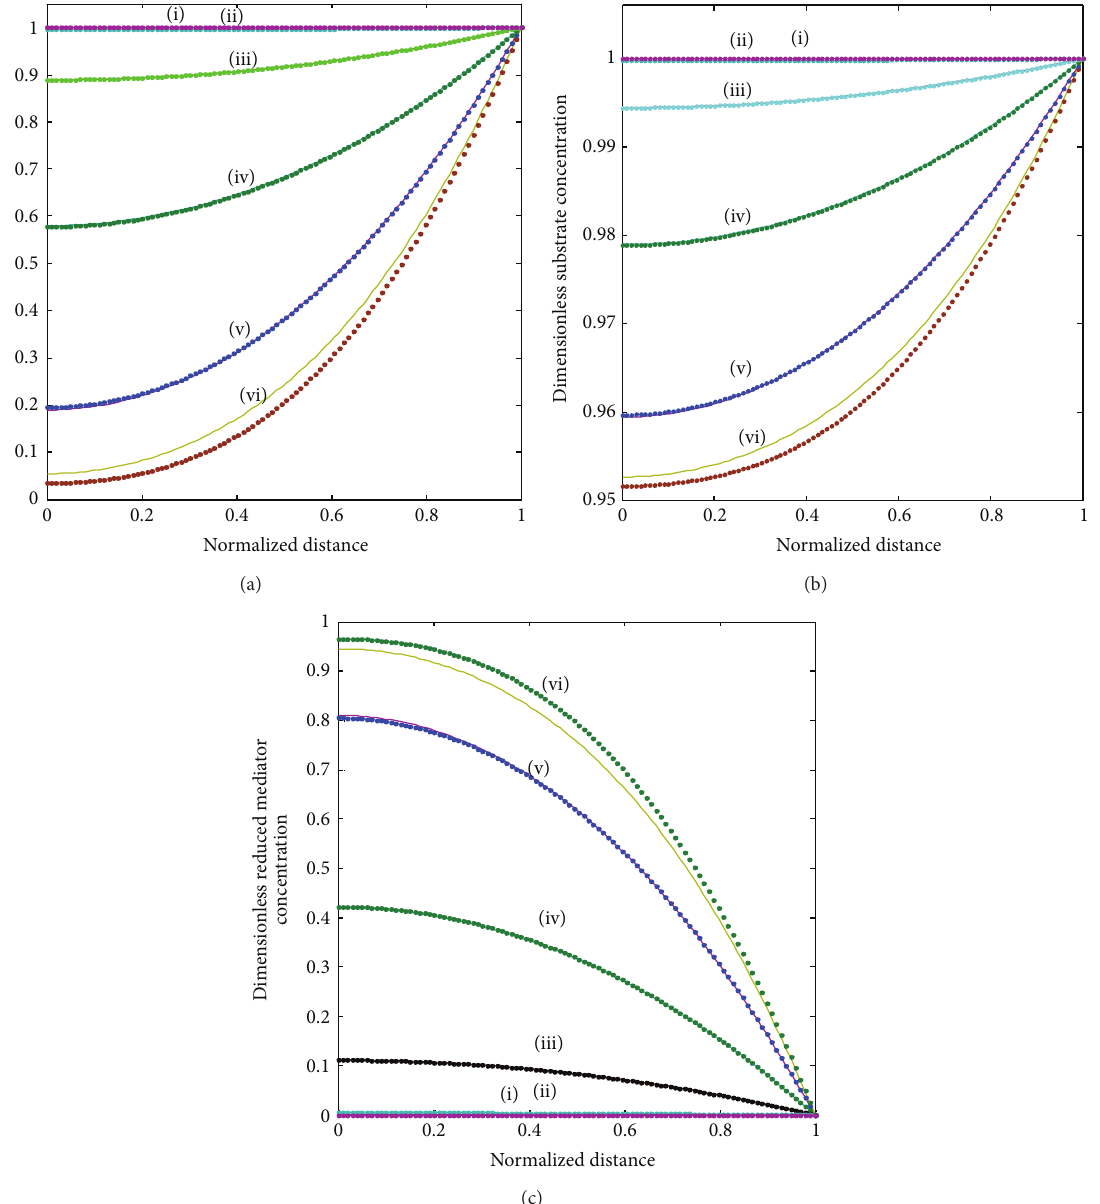
Figure 3: Dimensionless concentration of (a) oxidized mediator 𝐹 for some fixed values of parameters 𝐵 analytical solution whereas the dotted lines represent the numerical solution. (i) 𝜙 2 = 25 ( 𝑑 = 39.39 𝜇 M). (iv) 𝜙 2 𝜙 2 O